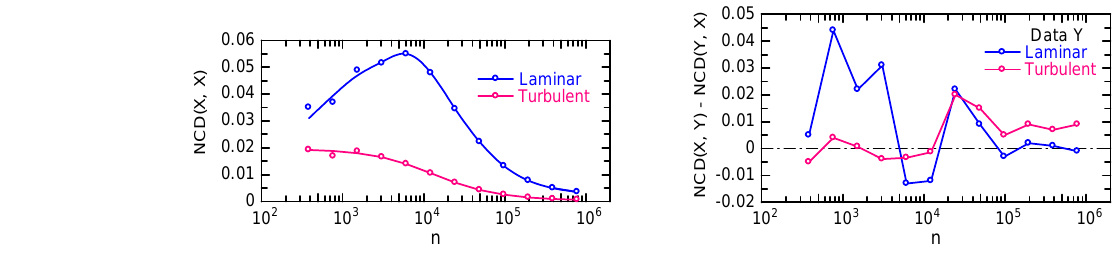
Fig. 1 Distribution of NCD between same data Fig. 2 Difference of NCD( X , Y ) and NCD( Y , X ) as a function of data length. as a function of data